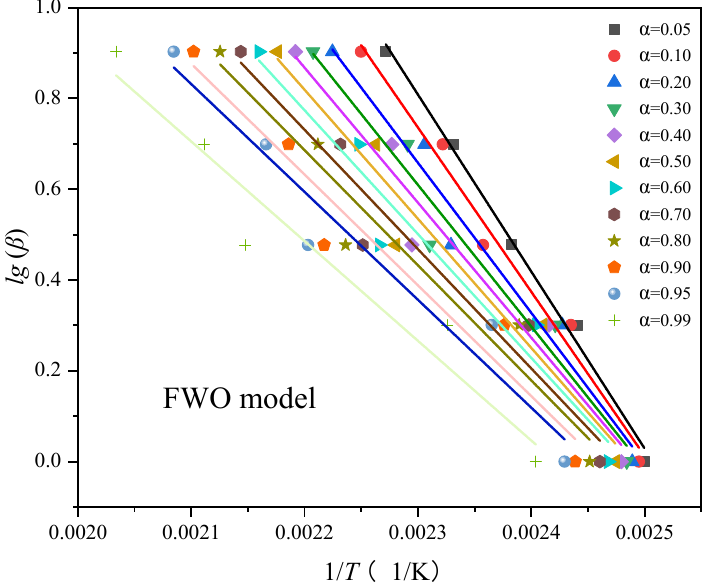
Figure 8. In the DSC experiment, differential analysis of PSS + (NH 4 ) 2 SO 4 under FWO model. The fitting results through the linear relationship between ln ( α ) and 1/ T in Vyazovkin model is shown in Figure 9. Among them, the calculated value of E a is higher with the decrease of the fitting degree. The average value of E a is 46.9087 kJ/mol, and the R 2 is 0.9006. The KAS model was used to calculate the average E a of PSS + (NH 4 ) 2 SO 4 —results are shown in Table 4. As the value of α is less than 0.3, the value of E a is greater than 50 kJ/mol. On the contrary, the value of E a decreases continuously and is less than 50 kJ/mol when the value of α is greater than 0.3. The average value of E a is 47.0870 kJ/mol, and the R 2 is 0.9417.